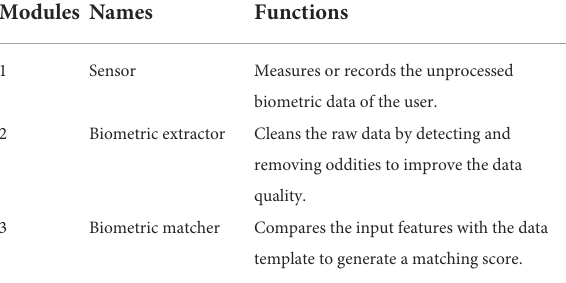
TABLE 2 Technical modules of the biometric authentication process (Liu et al., 2017; Mahfouz et al.,